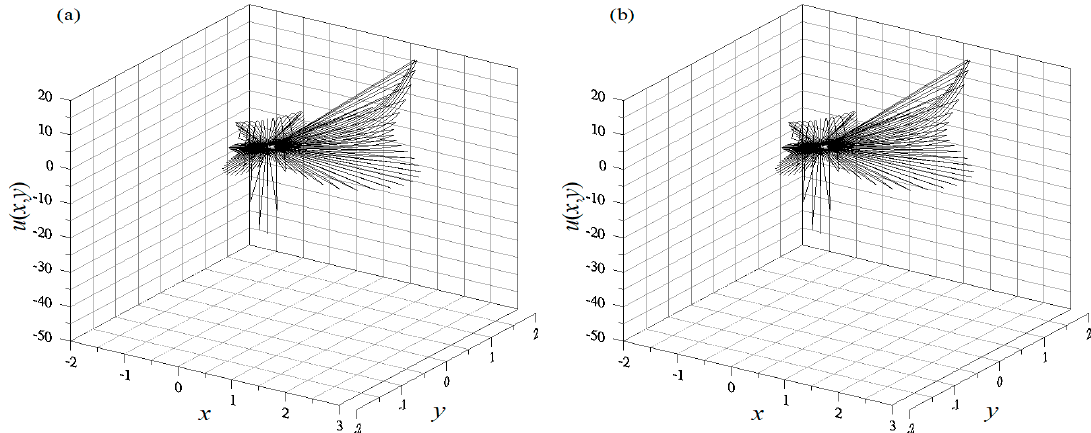
Figure 8. The exact solutions for the steady-state AC equation with amoeba-like irregular domain are shown in ( a ), and in ( b ) the proposed approach solution without random noise.